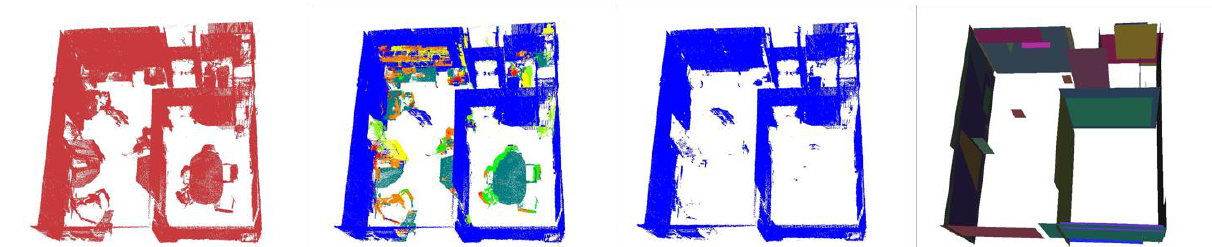
Figure 1. The input and outputs of the method; a) raw point cloud of the cluttered indoor environment; b) direct application of previously trained CNN classifier to the test site; c) selection of the wall points determined by the CNN; d) the result of the planar extraction, applied only to the corresponding wall